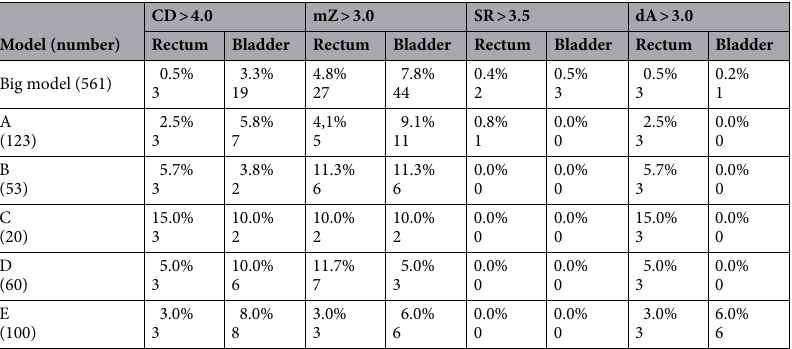
Table 5. Ratio (%) and the number of outliers for each index. CD Cook’s distance; mZ Modified Z-score; SR Studentized residual; dA Areal difference of estimate.